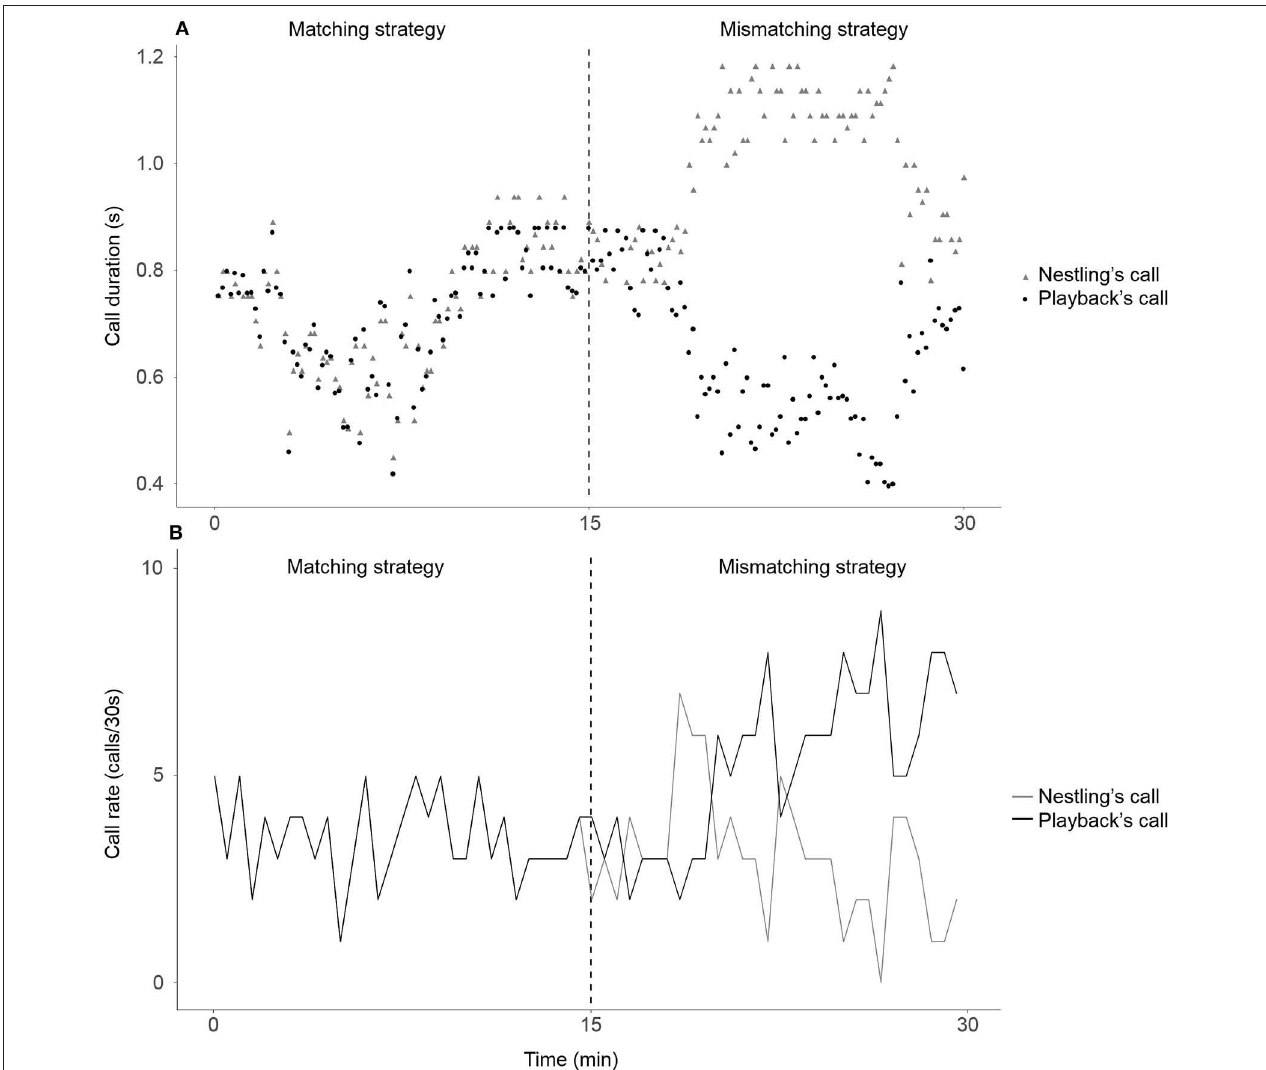
FIGURE 1 | An example of two periods of interactive playback experiment on call duration (A) and on call rate (B) . The computer program automatically detects the calls produced by a nestling and measures its duration. Then, the program compares this duration (or respectively rate) to that recorded in the previous 10s period. According to this change, it chooses to broadcast a call of a duration (or respectively rate) based on one of two pre-programmed calling strategies: under the matching strategy (left panels), the playback changes its call duration (or respectively rate) similarly to the nestling, while under the mismatching strategy (right panels), changes its call duration (or respectively rate) reversely to the nestling. The strategies were repeated four times each for 15min and were randomly ordered across the